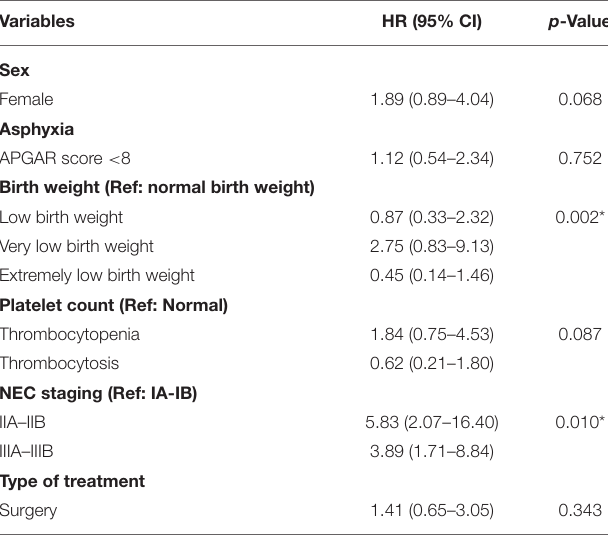
TABLE 2 | Association between prognostic factors and survival of neonates with NEC in our institution. Variables